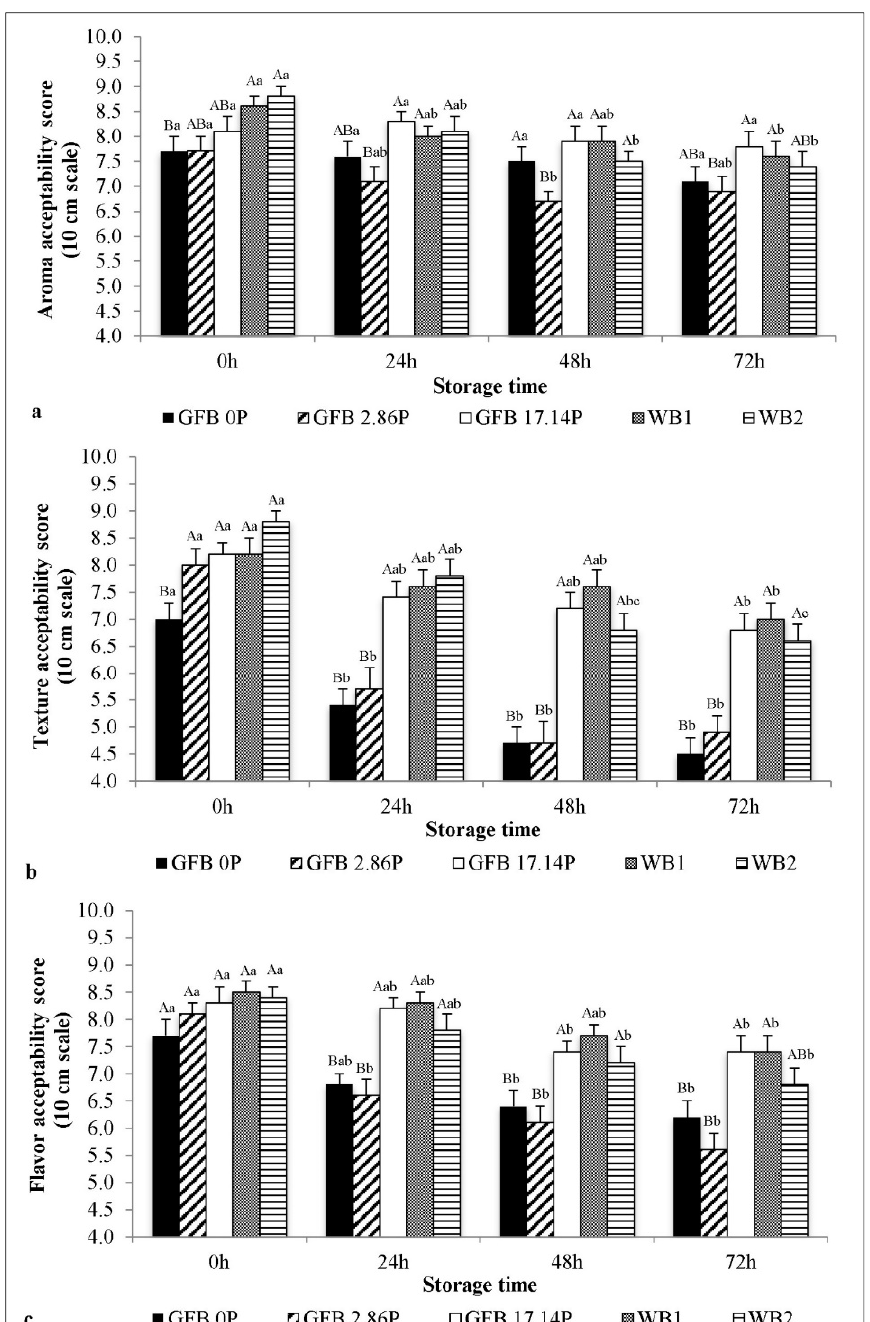
Figure 3. Acceptability scores for the aroma ( a ), texture ( b ) and flavor ( c ) of gluten-free bread (GFB) formulations containing different psyllium levels (GFB2.86P and GFB17.14P) 0, 24, 48 and 72 h post-production and their comparison to the control (GFB0P) and wheat counterparts (WB). The GFBs samples GFB0P, GFB2.86P, and GFP17.14P were prepared with 0.00, 2.86, and 17.14 psyllium (g/100g flour basis), respectively, and with adjusted water levels. WB1—standard wheat bread formulation, WB 2—adapted wheat bread formulation. Bars represent the mean values (n = 54); error bars represent the standard deviation. Bars with different lowercase letters within the same bread type are significantly different (p < 0.05). Bars for a given storage time with different capital letters are significantly different (p < 0.05).